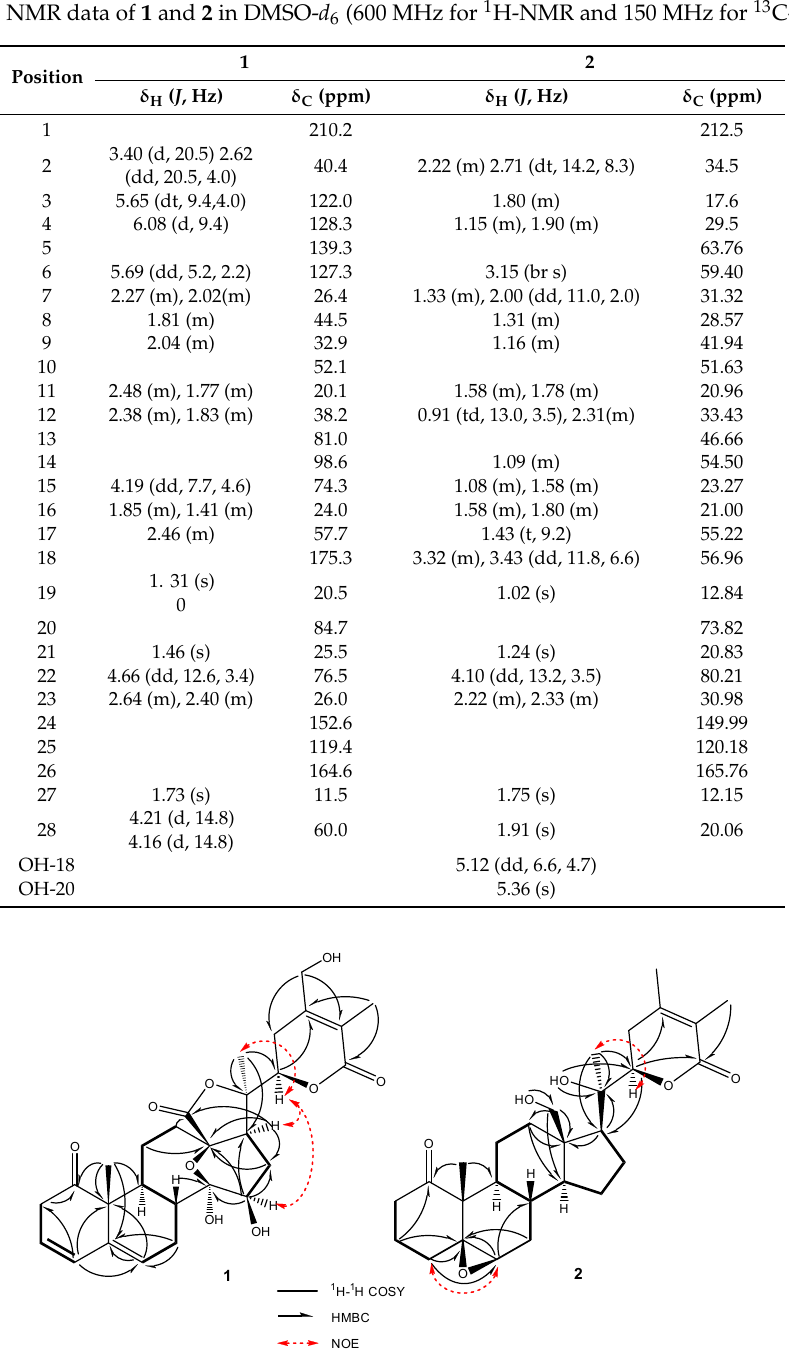
Table 1. NMR data of 1 and 2 in DMSO- d 6 (600 MHz for 1 H-NMR and 150 MHz for 13 C-NMR).